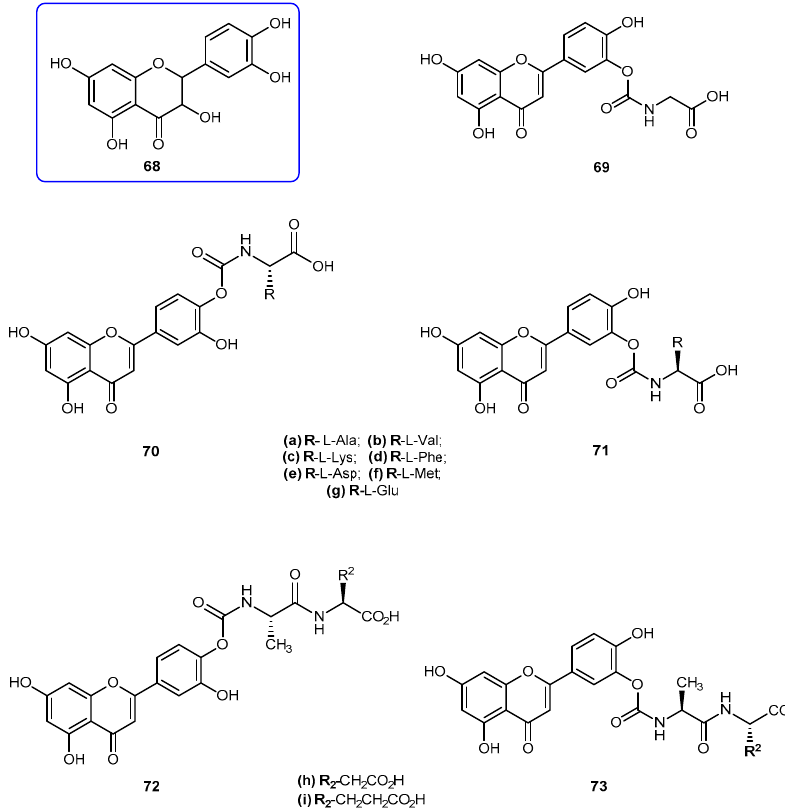
Figure 29. Quercetin ( 68 ), prodrug QC-12 ( 69 ) and its amino acids 70 – 71 and dipeptides 72 – 73